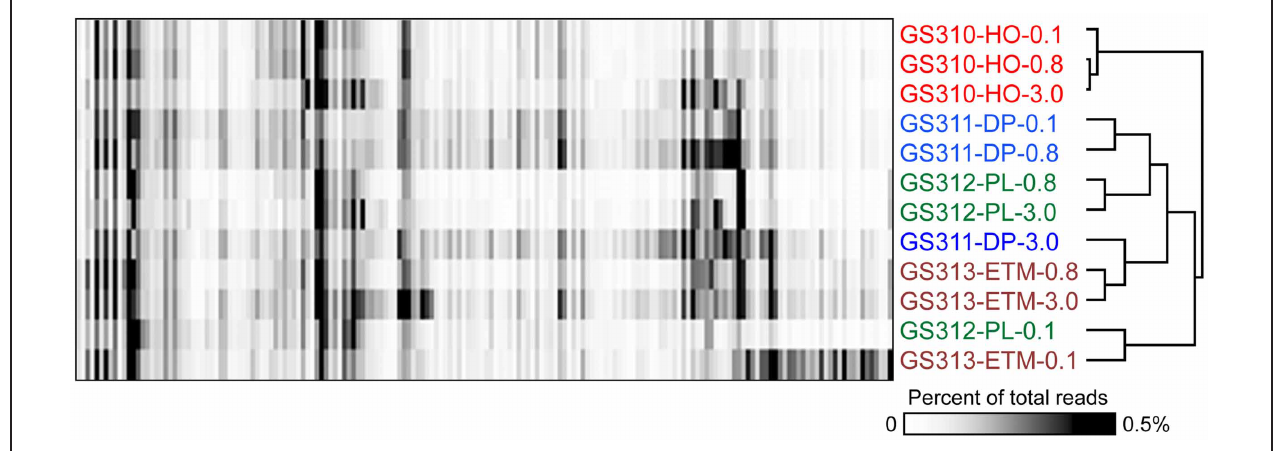
FIGURE 11 | 2D Hierarchical clustering (complete linkage) of bacterial families (X-axis) in metagenomes (Y-axis). In total, 117 bacterial families representing ≥ 0.1% of all annotated prokaryotic peptides (with ≥ 60% sequence identity over > 70% of the alignment length) in at least one metagenome were selected for analysis. For each family, abundance was calculated as the percentage of all corresponding hits to total